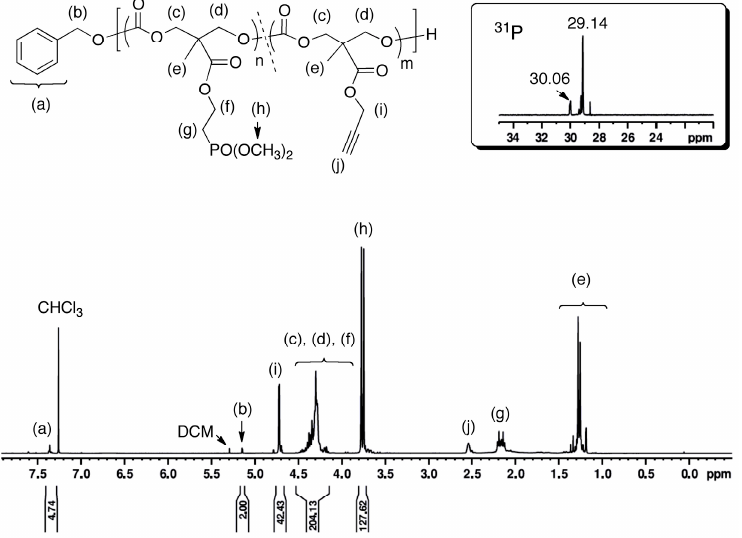
Figure 4. Overlaid 1 H ( bottom ) and 31 P NMR ( top-right corner ) spectra of phosphonate-functionalized poly[( 4 ) 21 - co -MPC 21 ] copolymer in CDCl 3 .